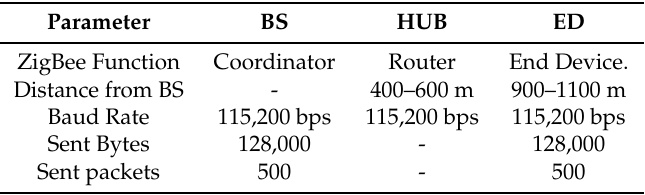
Table 5. Scenario 1: Configuration and position nodes.